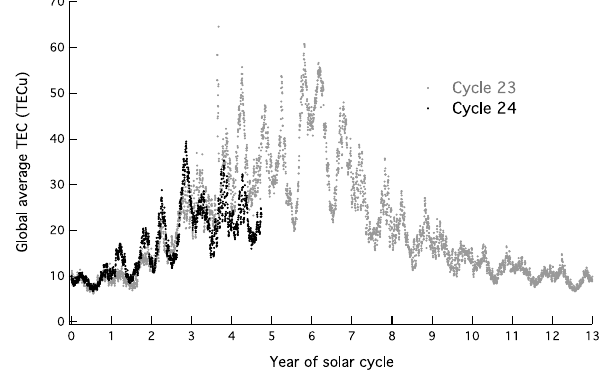
Figure 5. Similar to Fig. 4, but displayed are the monthly mean TEC of both SC23 and SC24. The standard deviations ( ± 1 σ ) about the monthly mean TEC of SC23 are shown in dotted and dashed lines as